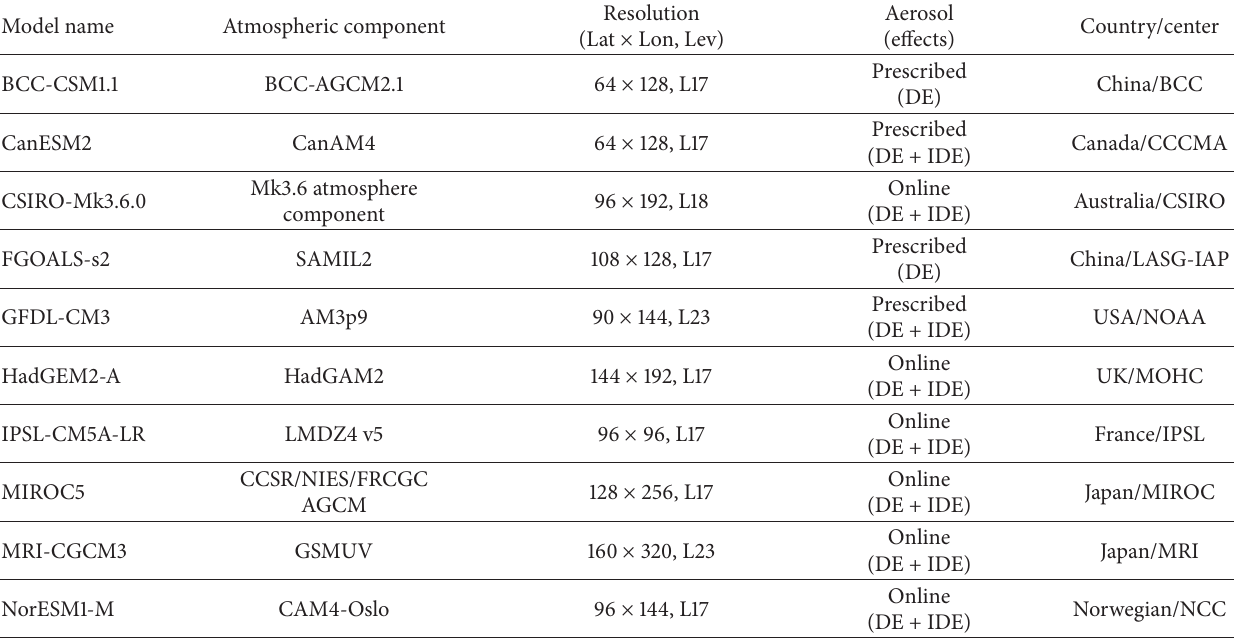
Table 1: List of the CMIP5 models used in this